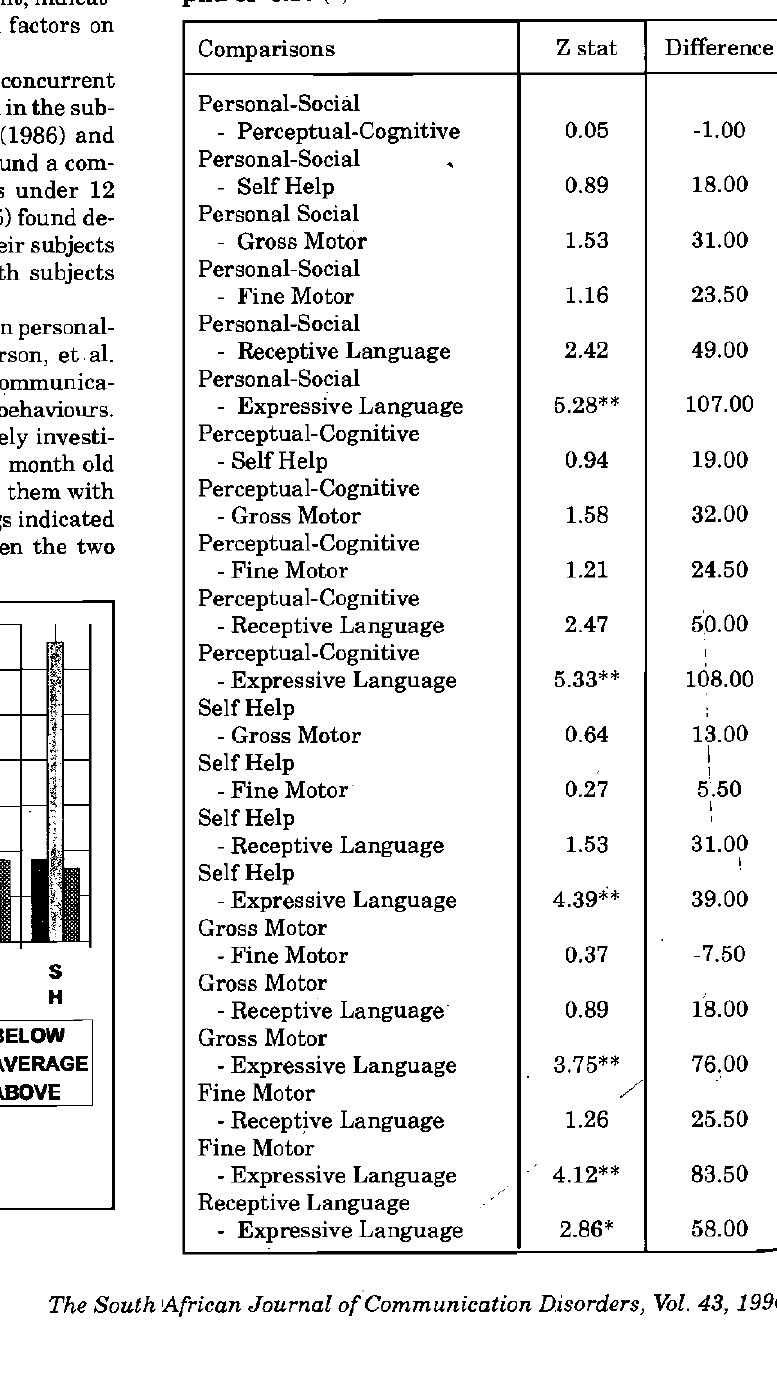
TABLE 4. Multiple comparisons performed for Friedman two way analysis of variance test. Criti- cal Ζ values indicating a significant difference: <3.04